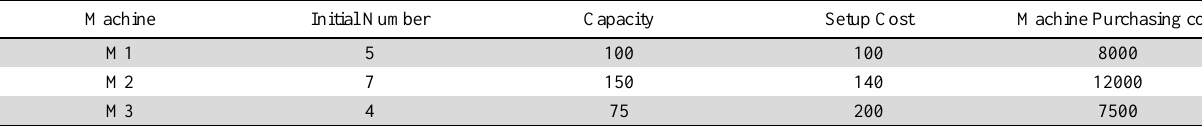
Machine dataset for experiment number 1